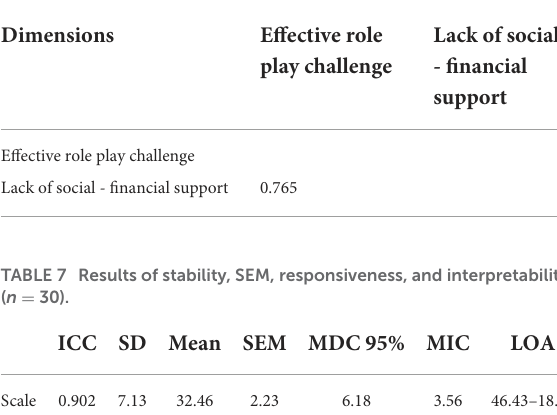
TABLE 6 Results of HTMT of CCS ( n